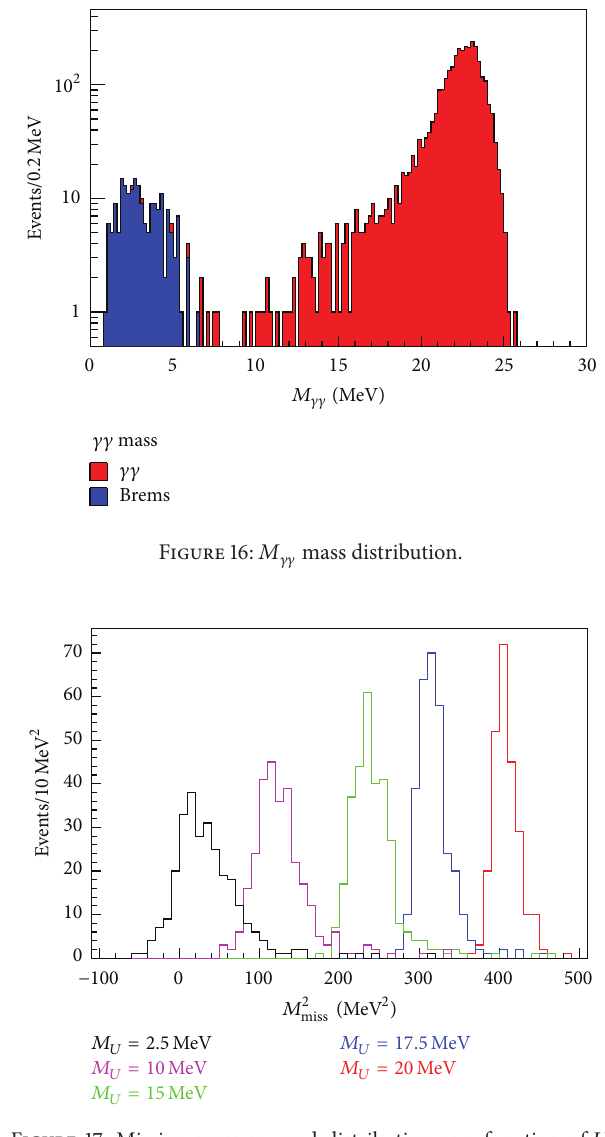
Figure 17: Missing mass squared distribution as a function of 𝑈 boson